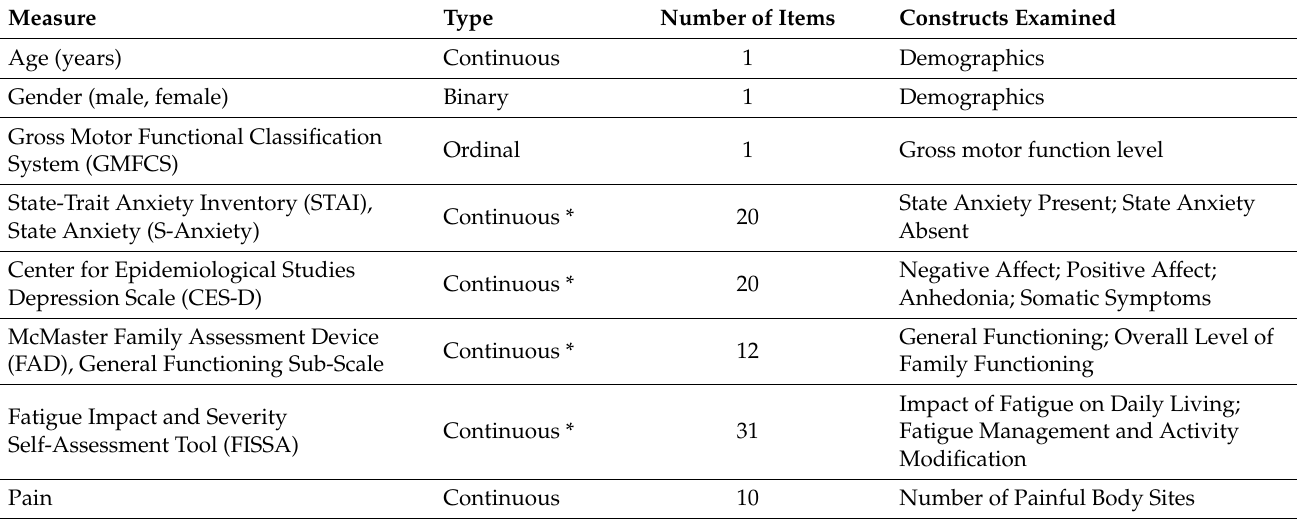
Table 1. Variables included in the